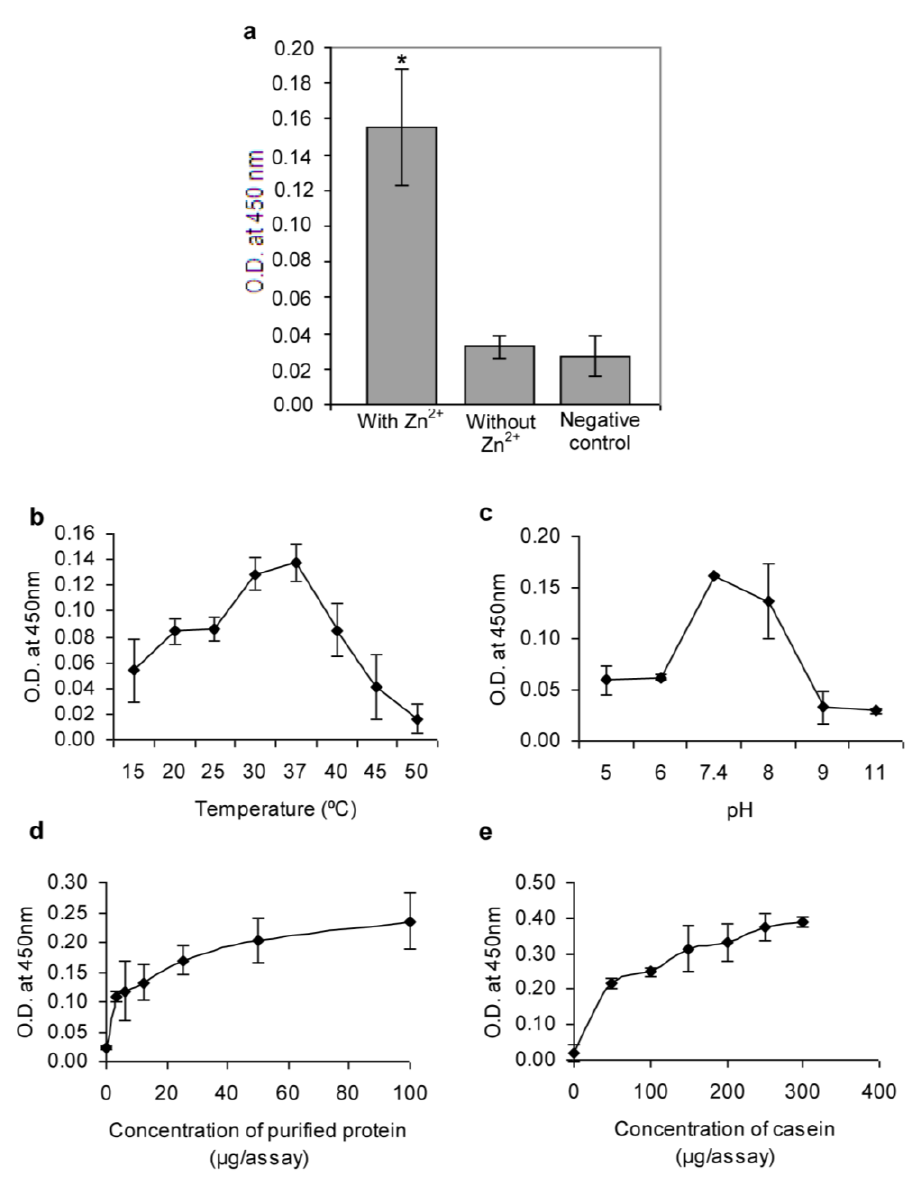
Figure 5. Effects of Zn 2+ ( a ), temperature ( b ), pH ( c ), enzyme concentration ( d ), and substrate concentration ( e ) on the proteolytic activity of K. pneumoniae YggG. The protease activity was determined as the rate of succinylated casein hydrolysis. All the reactions were performed in triplicate and the data were plotted as their mean ± standard deviation. Asterisk indicates statistically significant difference ( p <